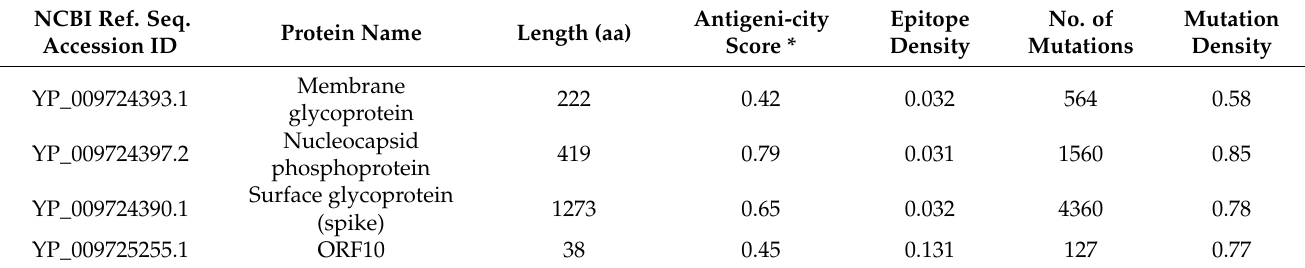
Table 1. B-cell antigens of SARS-CoV-2 and their corresponding antigenicity scores *, epitope density, number of mutations, and mutation density. NCBI Ref. Seq.